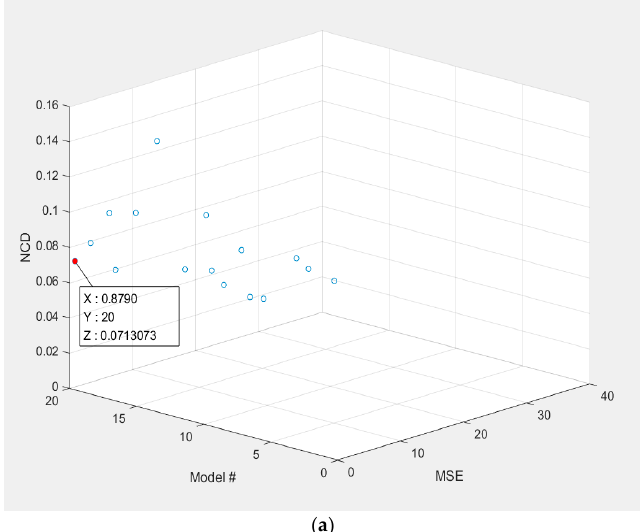
Table 8. Results for criteria and NCD value for comparison with dataset #2.